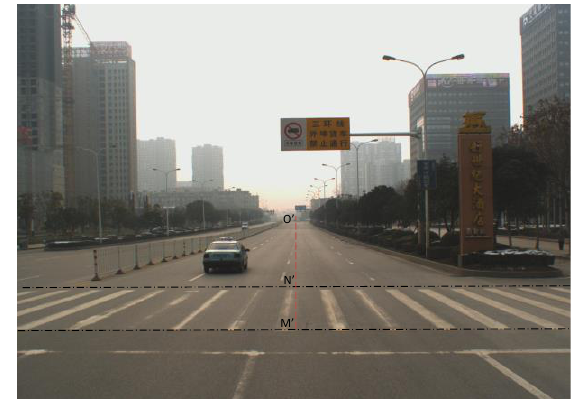
Figure 9. Interpretation of M’N’ and O’N’ in an image